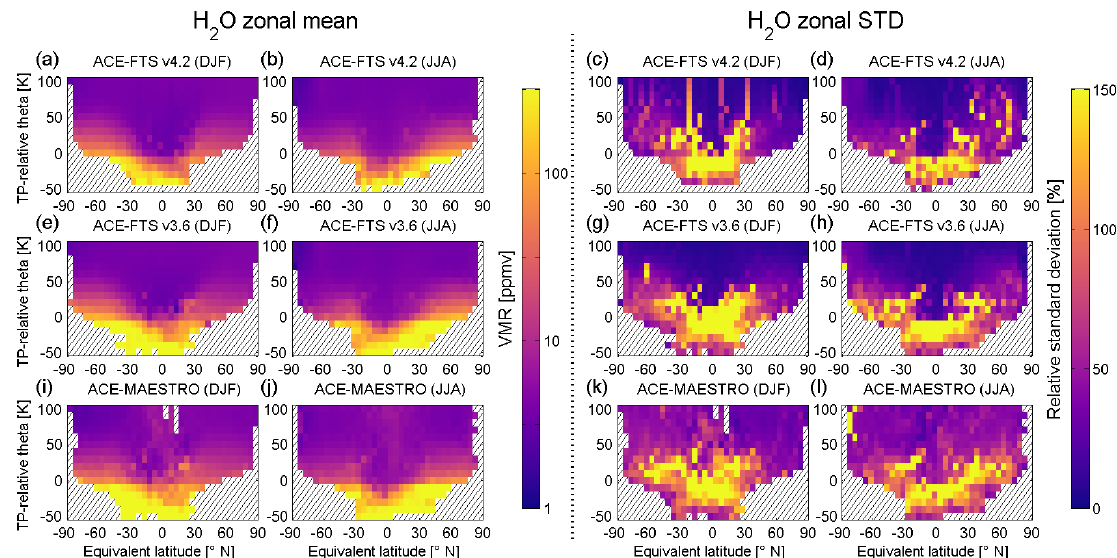
Figure 1. The 3-month zonal-mean multiyear-mean (June 2004 to May 2018) water vapour climatologies constructed from the ACE- FTS v4.2 (a–b) , v3.6 (e–f) , and MAESTRO (i–j) datasets for DJF (a, e, i) and JJA (b, f, j) in tropopause-relative potential temperature and equivalent-latitude coordinates. Also shown is the relative standard deviation for DJF (c, g, k) and JJA (d, h, l) . Gaps in the data occur when there are either no observations made or fewer than five observations available for a given bin. Note the addition of hatching to the plots where there are no data